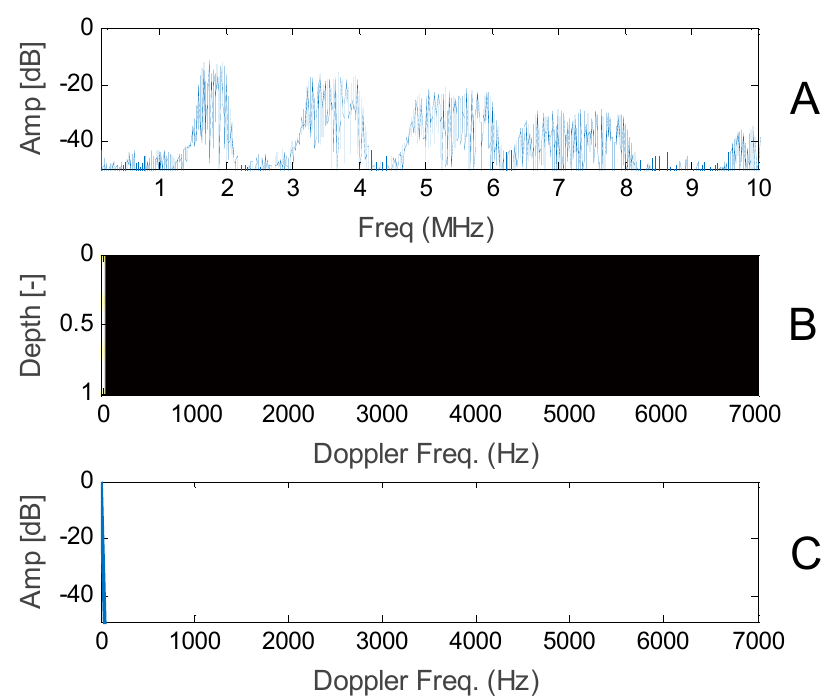
Figure 6. Simulation of the noise produced by a switching regulator modulated with a triangular frequency between 1.6–2.0 MHz, in an acquisition with T Pri = 143 µ s. ( A ) Spectrum of the noise as input into the Doppler system; ( B ) Doppler spectral matrix; ( C ) spectral density averaged over depths ( k -index). The constraints in Equation (21a) and Equation (21b) are verified, and artifacts are moved at frequency 0.